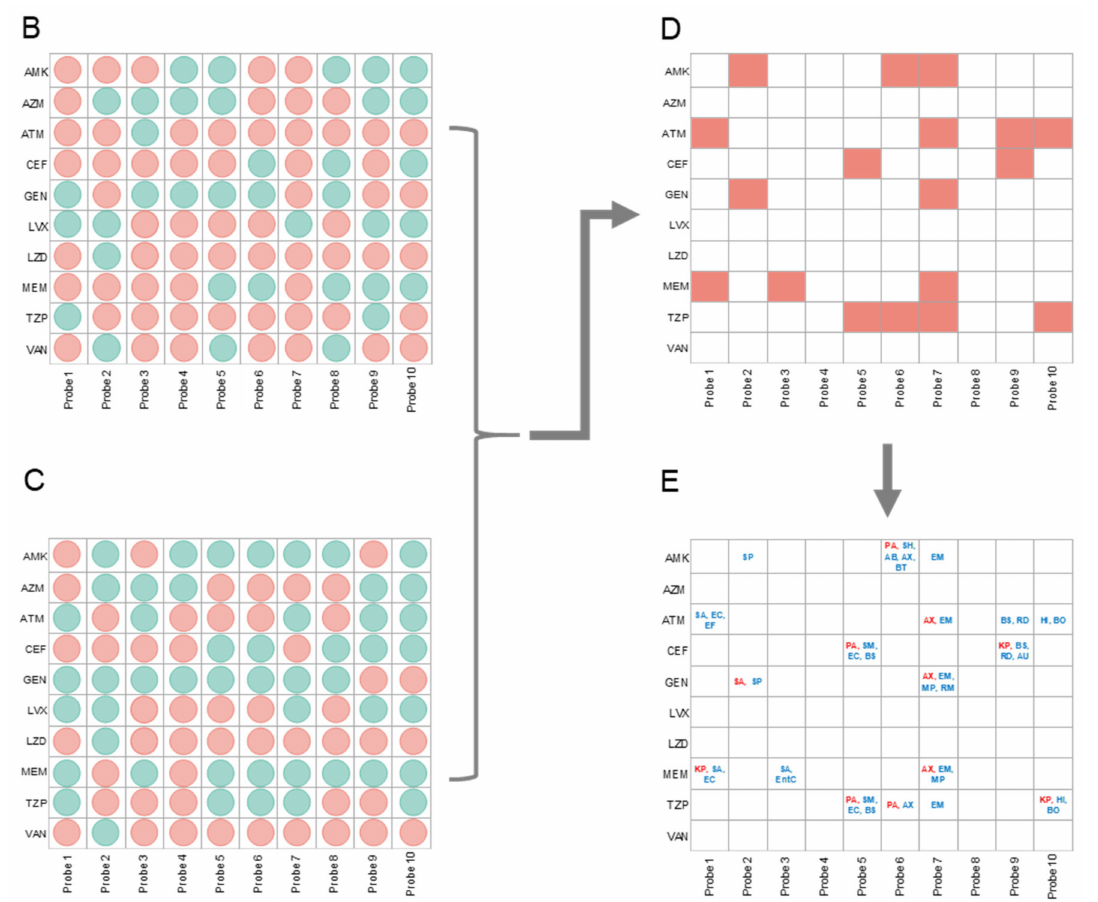
Figure 4. Selection of antibiotics for polymicrobial biological samples with AtbFinder compared with that achieved with a standard AST method.Antibiotics used: amikacin (AMK), azithromycin (AZM), aztreonam (ATM), cefepime (CEF), gentamycin (GEN), levofloxacin (LVX), linezolid (LZD), meropenem (MEM), piperacillin-tazobactam (TZP) vancomycin (VAN). ( A ) Comparison of the diversity of bacteria grown on TGV of AtbFinder (for 4 h) and on the standard medium used by AST (for 24 h). A. baumannii (AB) , A. xylosoxidans (AX), A. ursingii (AU), Bacillus spp. (BS), Bacillus obstructivus (BO), B. pumilus (BP), B. sonorensis (BS), B. thailadensis (BT), Enterobacter cloacae (EntC), Enterococcus faecalis (EF), Elizabethkingia miricola (EM), Escherichia coli (EC), Haemophilus influenzae (HI), K. pneumoniae (KP), Microbacterium paraoxydans (MP), Proteus spp. (PR), R. mucilaginosa (RM), R. dentocariosa (RD), S. anginosus (SAN), S. aureus (SA), S. maltophilia (SM), S. heamolyticus (SH), S. pneumoniae (SP). BAL—Bronchoalveolar lavage, CF—cystic fibrosis, CAP mommunity community-acquired pneumonia, HAP—Hospital-acquired pneumonia, COPD—Chronic obstructive pulmonary disease ( B ) Antibiotic efficacy